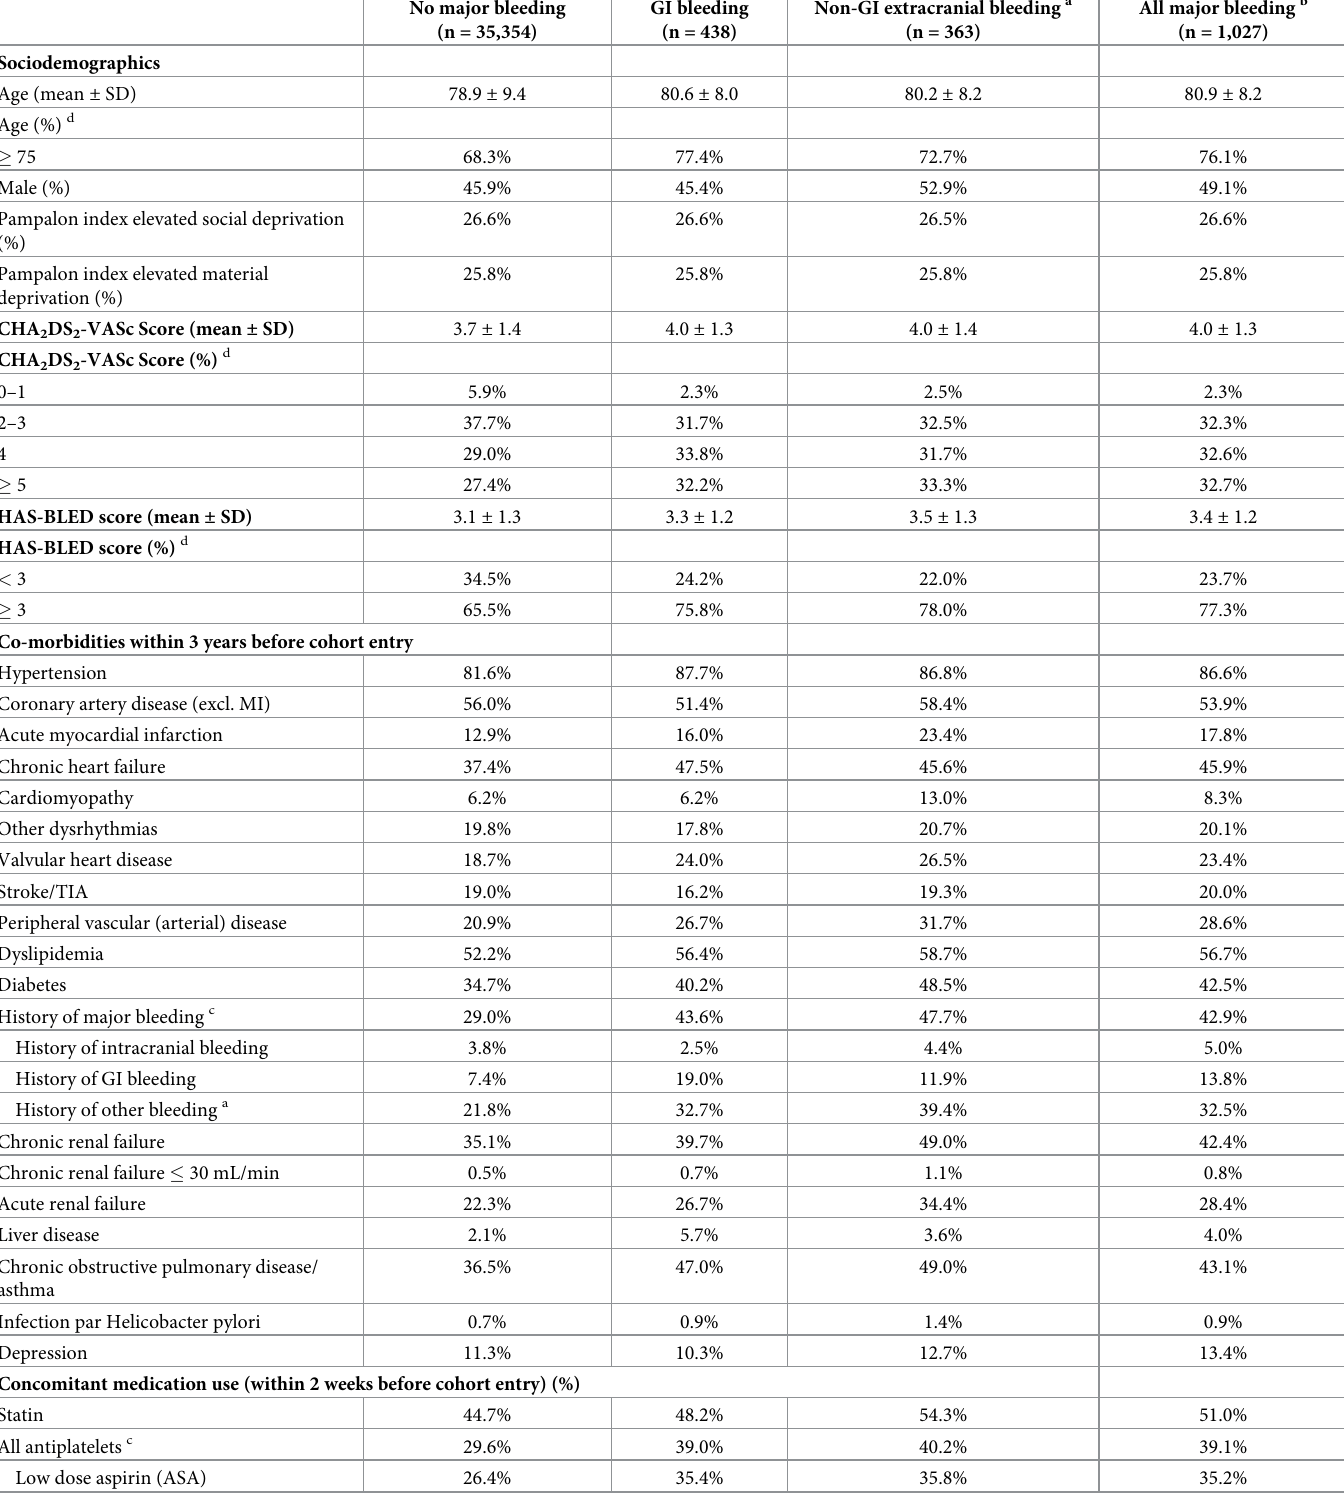
Table 1. Baseline characteristics of OAC new user with and without major bleed in the year of follow-up from 2011 to